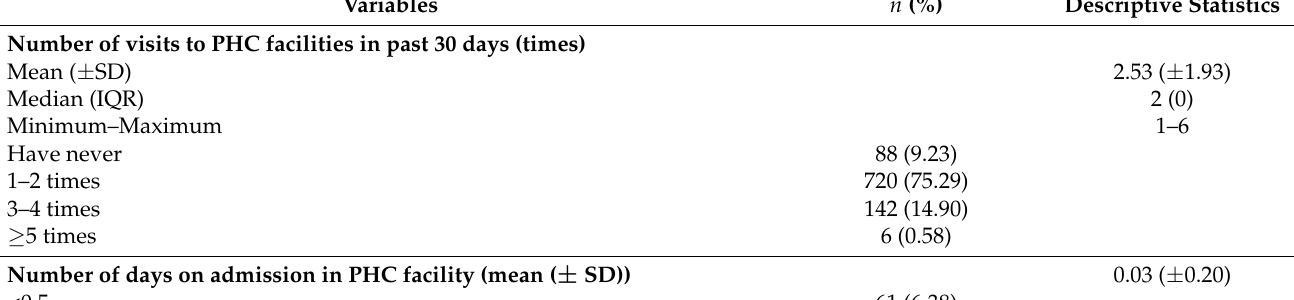
Table 1. Frequency distribution of patients’ cost variables for uncomplicated malaria ( N = 956). Variables n